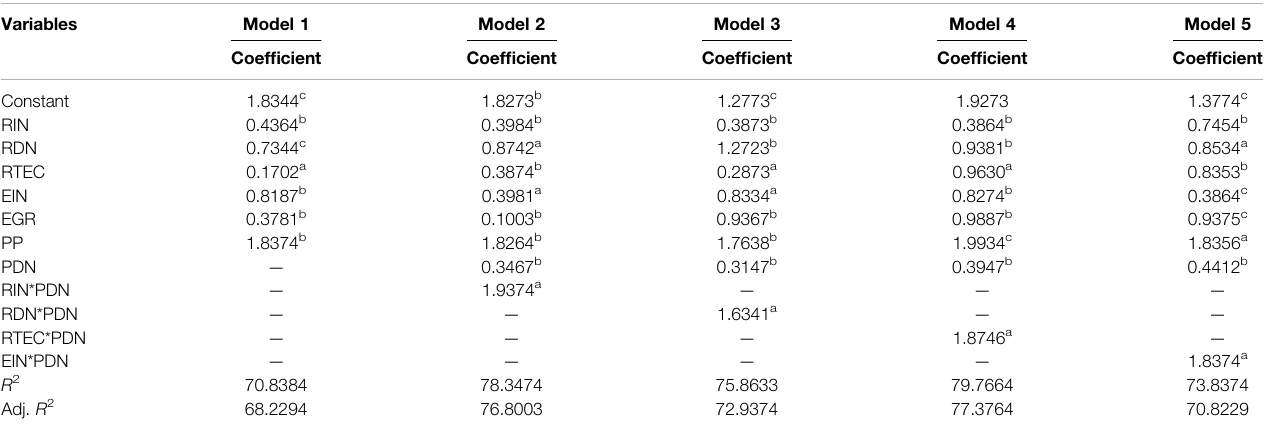
TABLE 7 | Fully modi fi ed ordinary least square